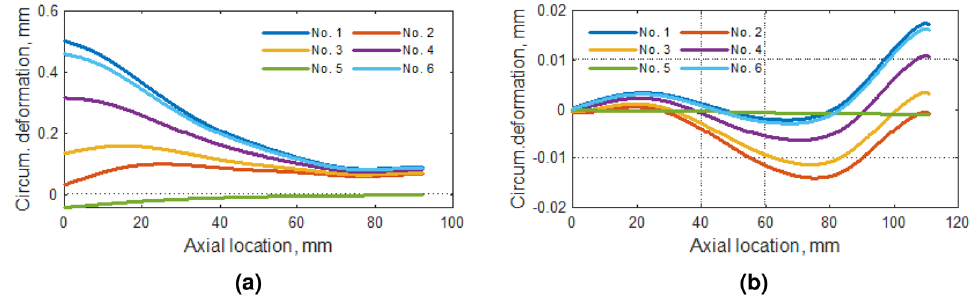
Figure 9. Circumferential deformation along with ( a ) the tip of the blade and ( b ) rounding between the blade and the hub of the compressor.